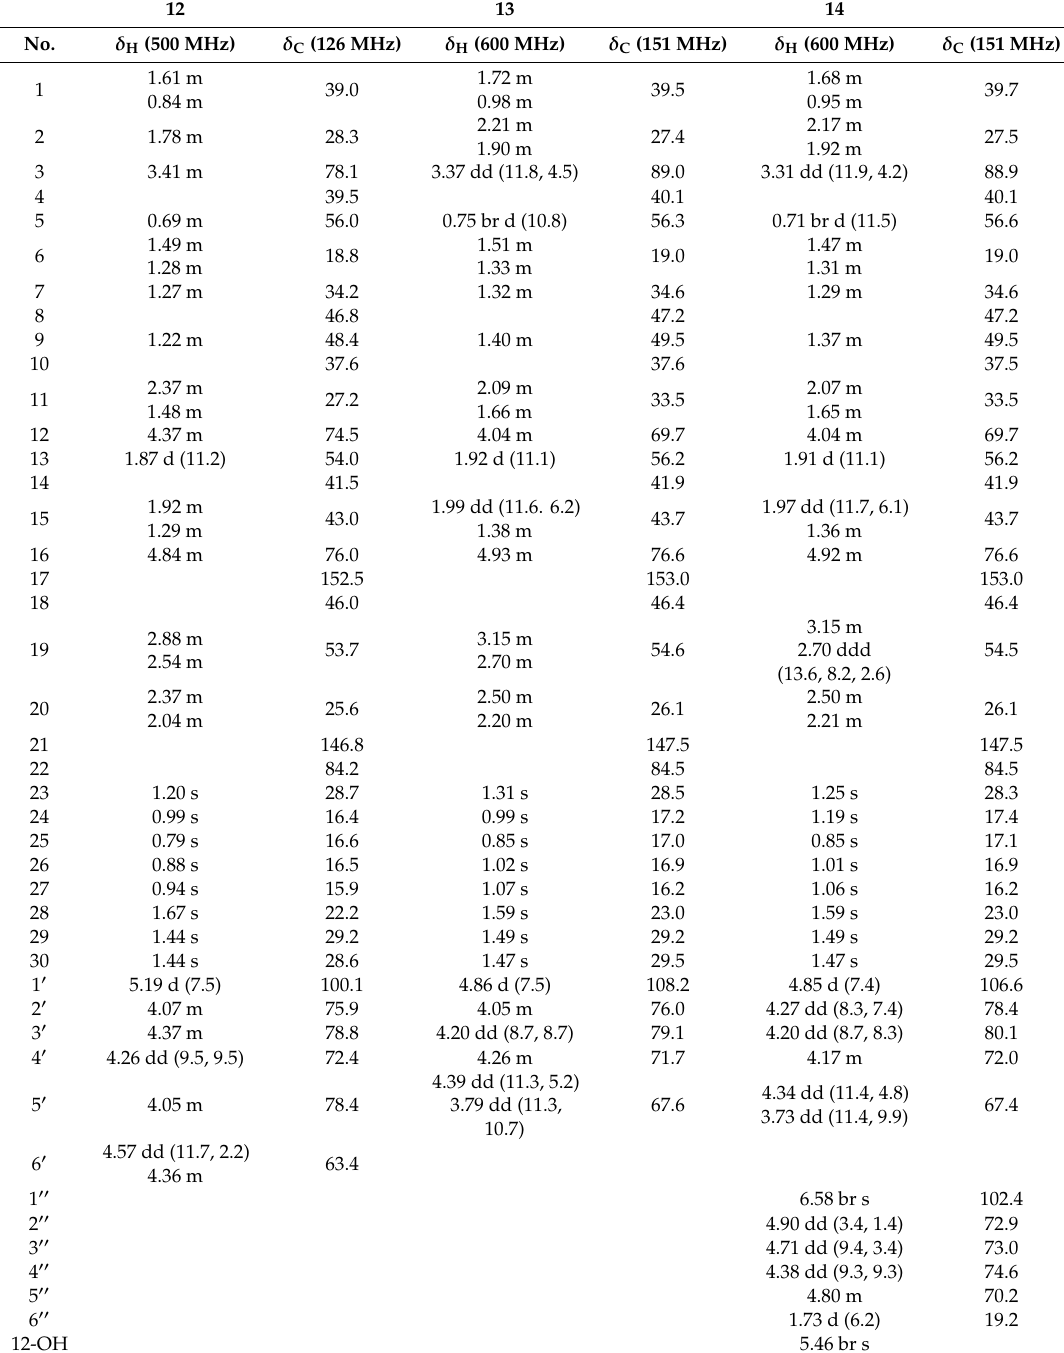
Table 5. 1 H and 13 C-NMR data of 12 – 14 in Pyridine- d 5 ( δ in ppm, J in